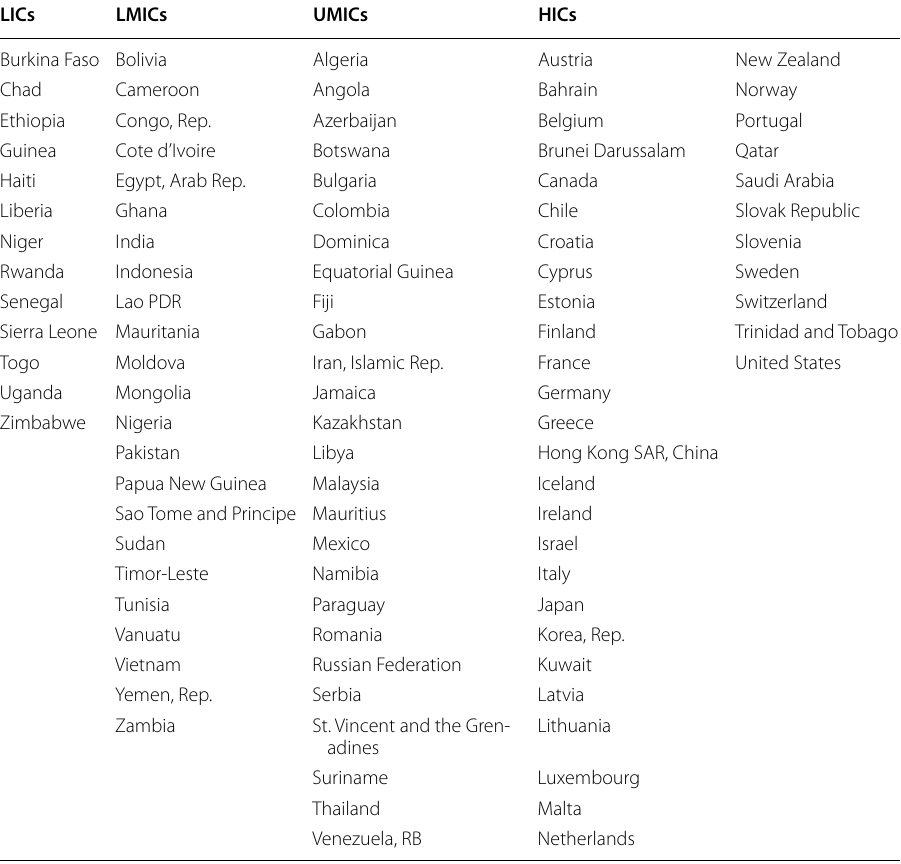
Table 8 List of the countries contained in the different sub-samples used in the analysis LICs